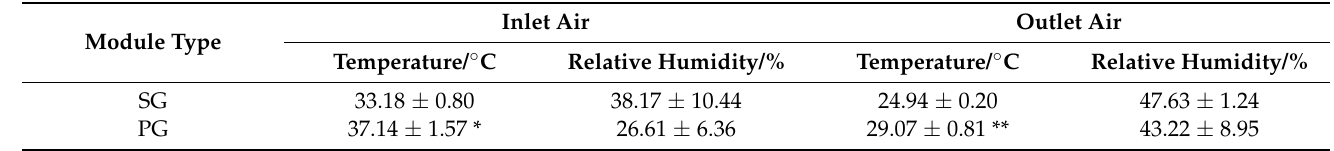
Figure 7. Temperature and humidity changes on typical cloudy days (24 February 2021 9:00–27 February 2021 9:00). ( a ) SG; ( b ) PG. Table 4. SPSS significance test of the average air temperature and humidity of the air inlet and outlet on a typical sunny